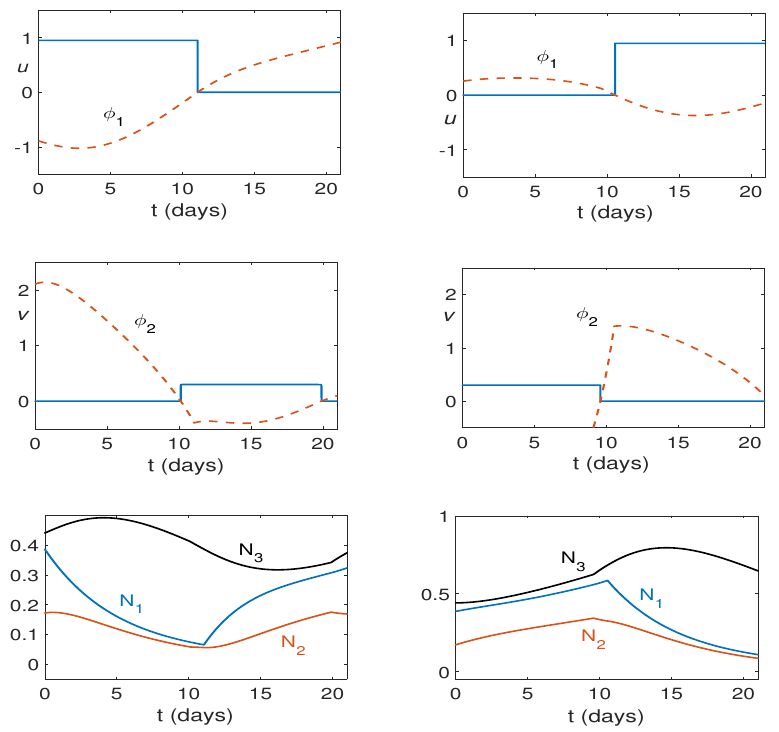
Fig. 6 Examples of locally optimal controls u (cytotoxic agent) (top), v (cytostatic agent) (middle) and their corresponding trajectories (bottom) for different weights r = ( 1 , 1 , 1 ) and q = ( 1 , 1 , 1 ) on the left and r = ( 8 . 25 , 8 . 25 , 8 . 25 ) and q = ( 0 . 1 , 0 . 1 , 0 . 1 ) on the right. The parameter values are given in Table